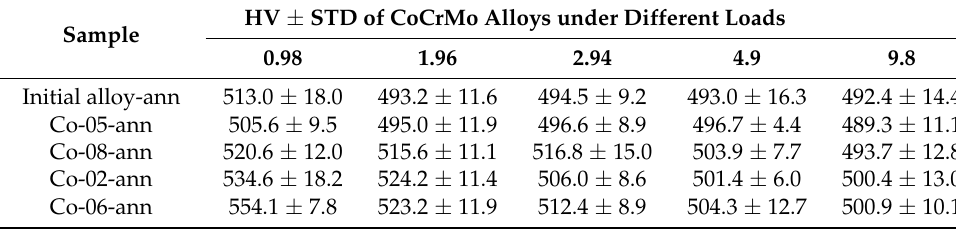
Table 3. Hardness (HV) and standard deviation (STD) of the initial CoCrMo alloy and recycled alloy specimens after heat